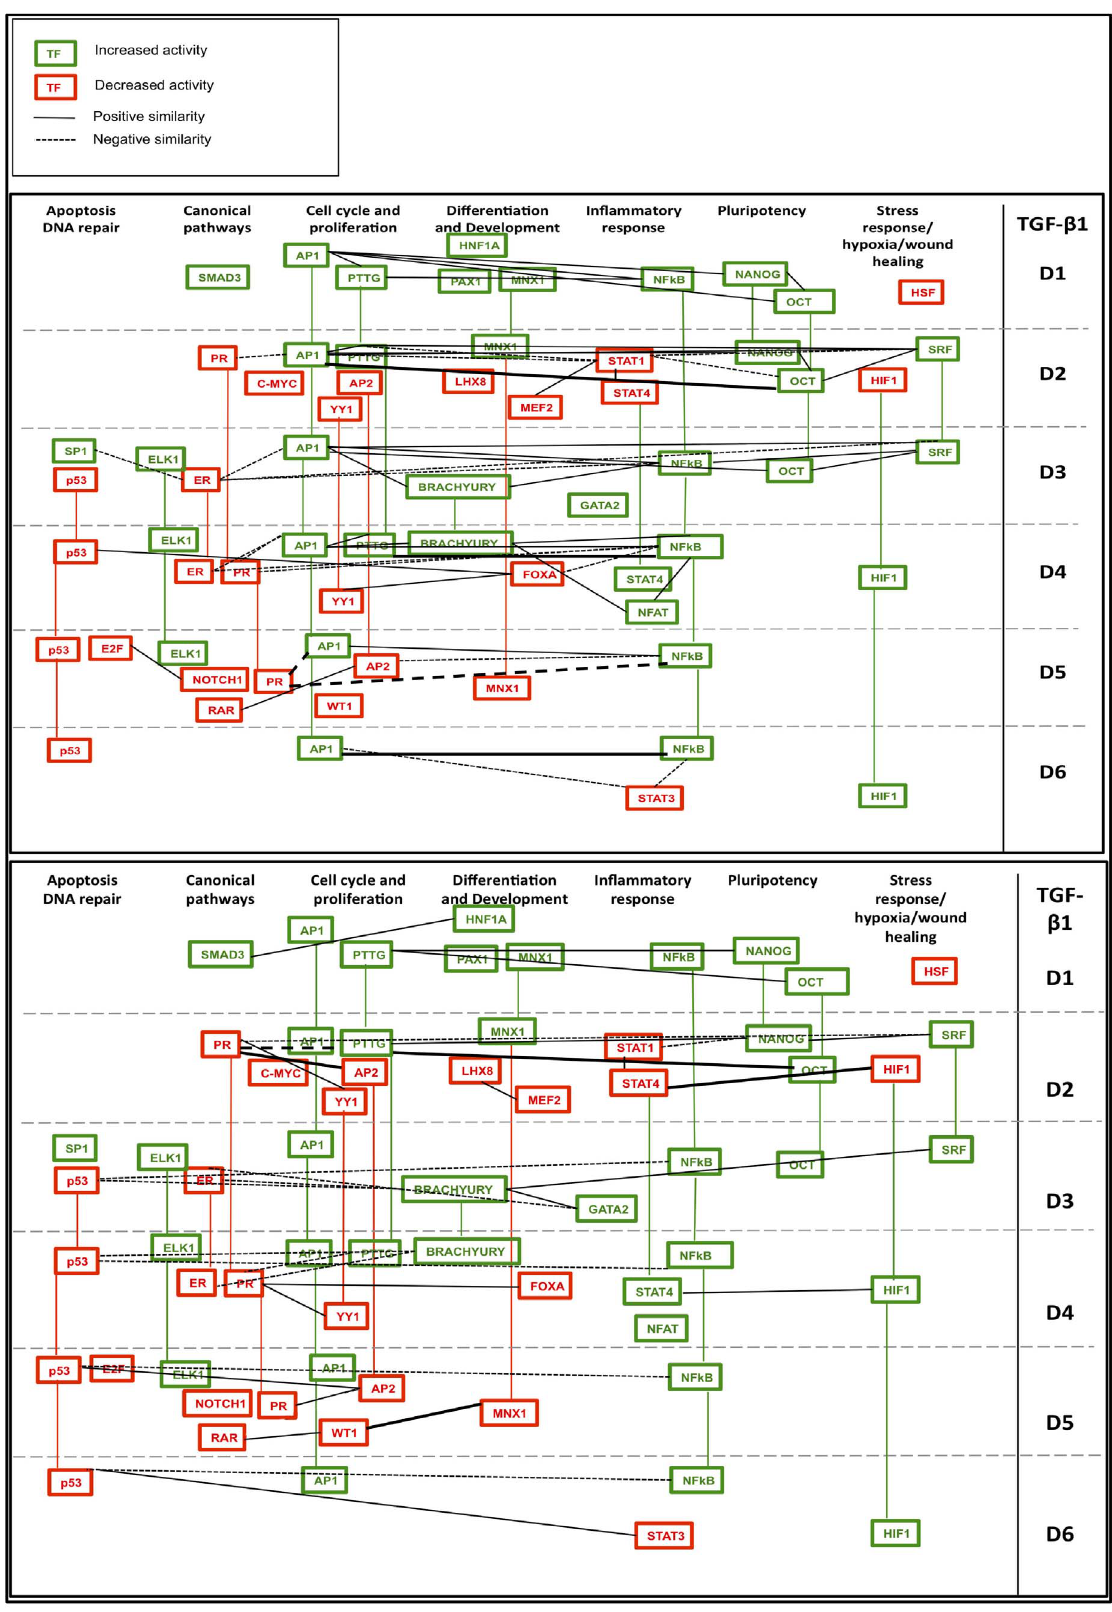
Figure 8. EMT at the level of dynamic TF activity networks in HMLE Twist ER cells treated with TGF- b 1. TF activities are plotted as in Figure 7. Top panel. Prior knowledge of TF interactions from the TRANSFAC database identified connections between TFs with reporters showing